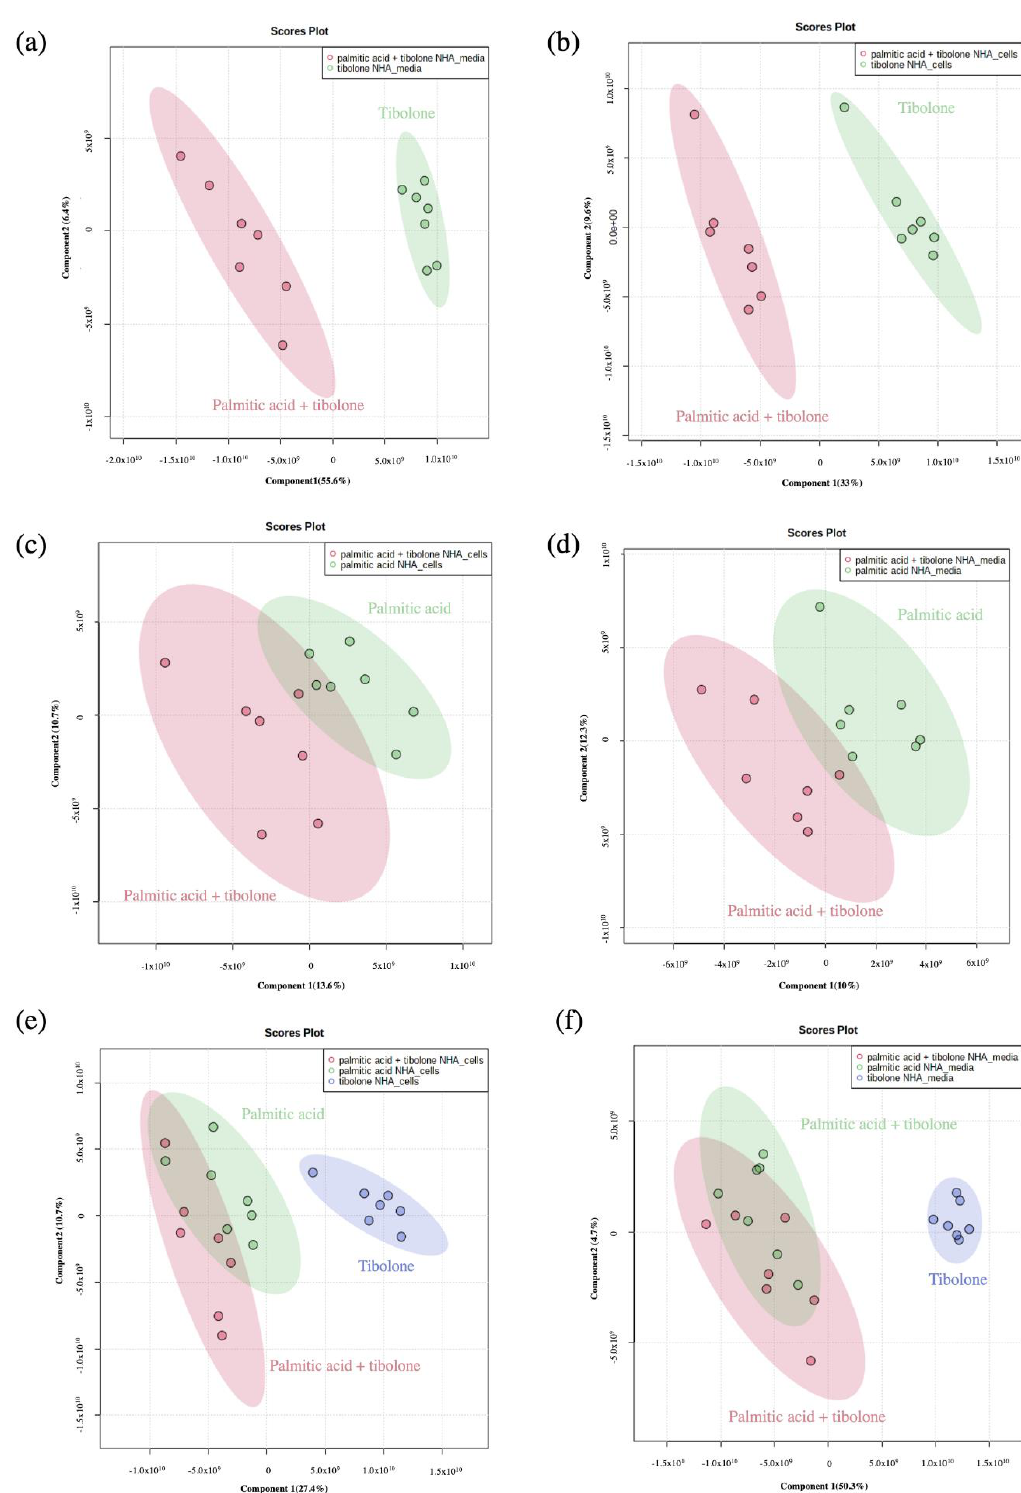
Figure 2. Partial least squares discriminant analysis (PLS-DA). ( a , b ) palmitic acid + tibolone (red) and tibolone (green). ( c , d ) palmitic acid + tibolone (red) and palmitic acid (green). ( e , f ) palmitic acid + tibolone (red) and palmitic acid (green) and tibolone (blue). ( a , c , e ) endometabolome and ( b , d , f ) exometabolme. The samples clustering together according with the tibone treatment. It was possible to determine that sampleas are not separate as cluster for PA and PA + T